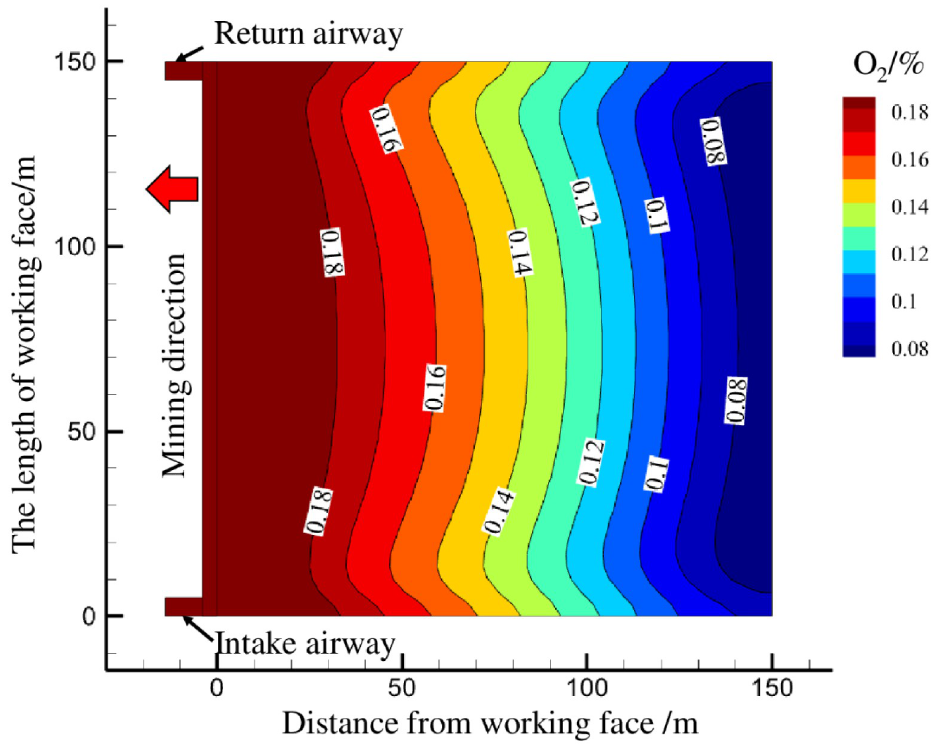
Fig 8. Distribution of oxygen concentration in the goaf.